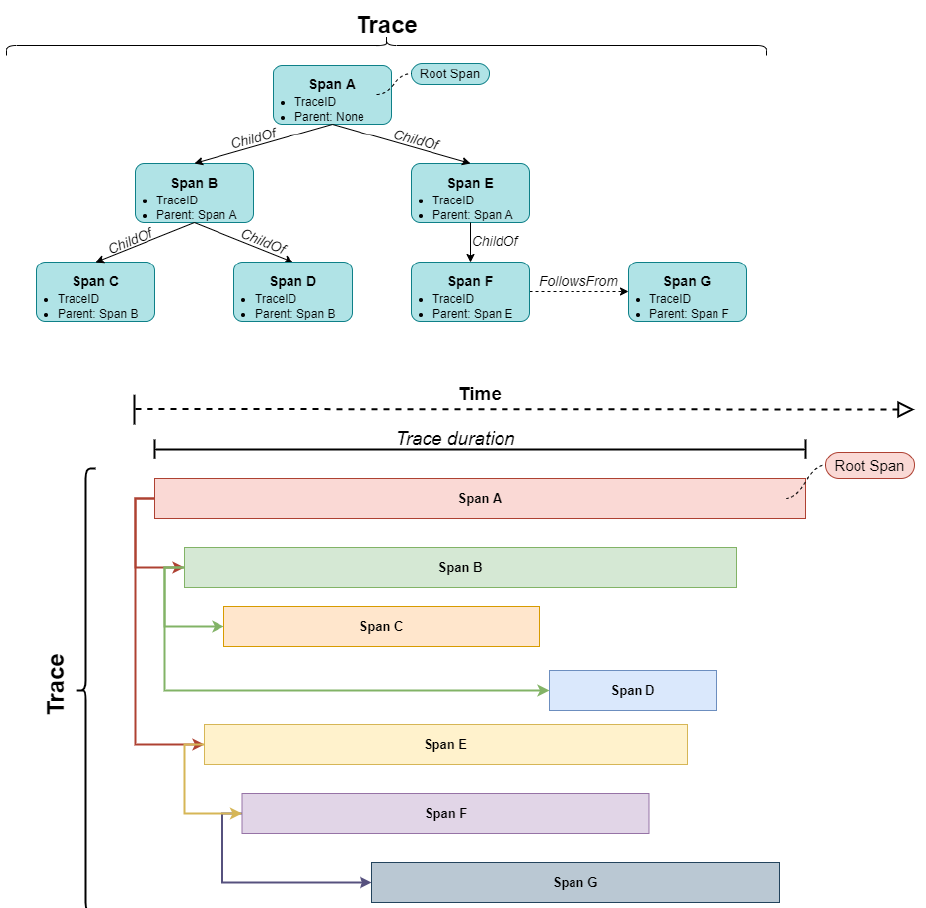
Figure 3. Distributed trace